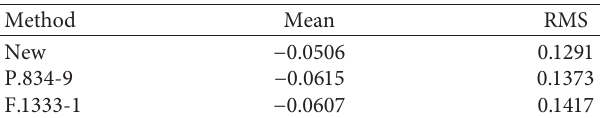
Table 5: Errors for an orbit of 36,000km for the low-latitude annual reference atmosphere when the apparent elevation angle is known (in